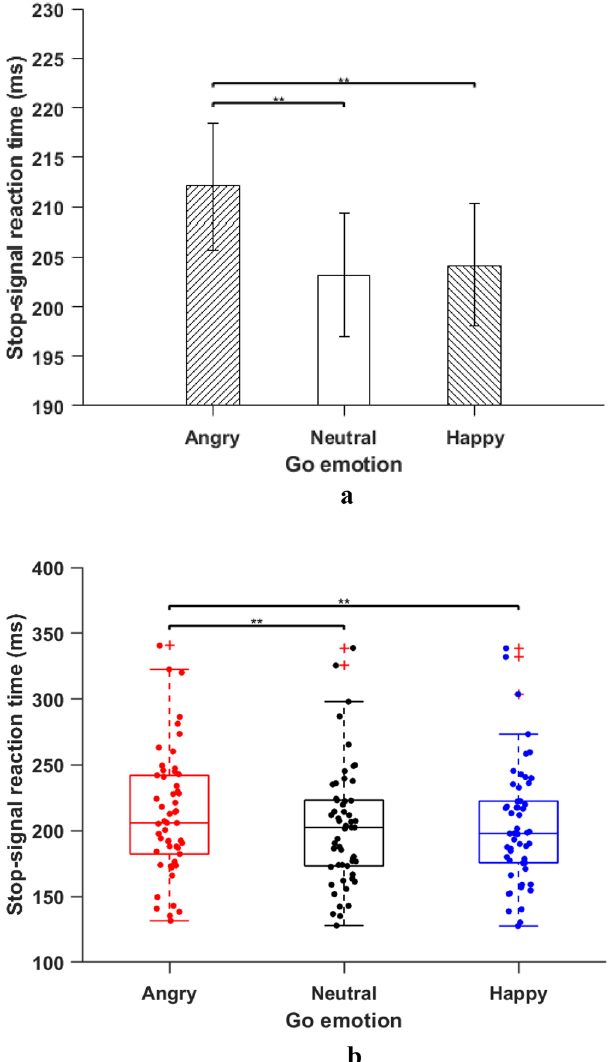
Figure 2. ( a ) Stop-Signal Reaction Time: Go emotion. Stop signal reaction time (SSRT) for three go emotions. Error bars indicate the standard error of the corresponding means. The SSRT for the angry go signal was significantly higher than SSRT for the happy and neutral go signal (see text). ** p < 0.001. ( b ) Box-plot distribution of a . Stop signal reaction time (SSRT) for three go emotions. The SSRT for the angry go signal was significantly higher than SSRT for the happy and neutral go signal (see text). ** p <